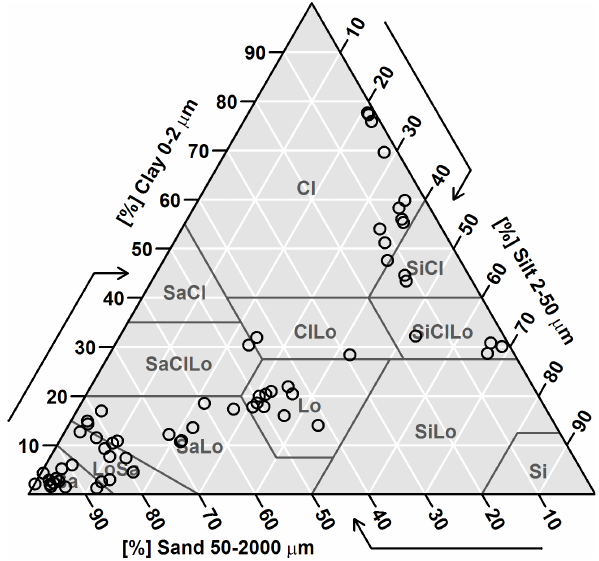
Fig. 1. Textures of the different horizons of the 16 soils used for our study, represented over USDA Soil Texture Triangle